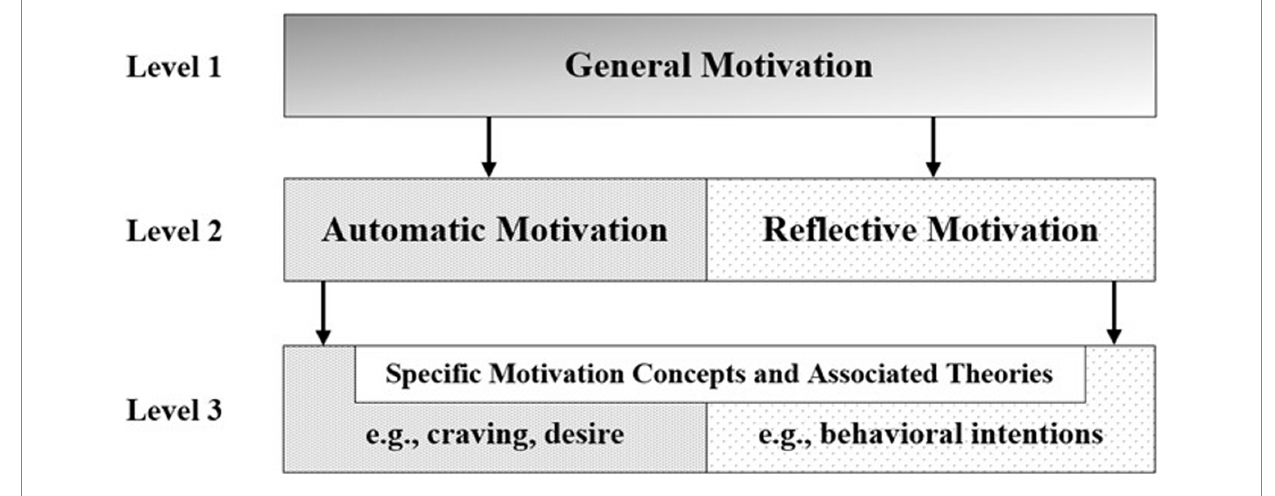
FIGURE 1 The automatic-reflective motivation